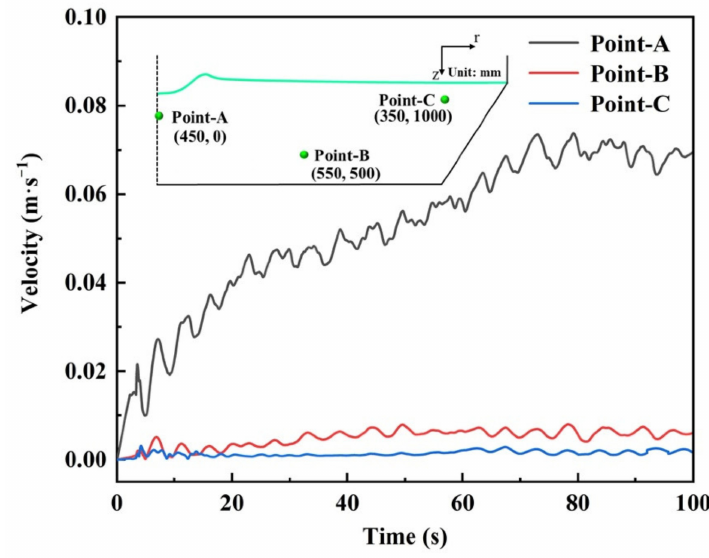
Figure 7. Velocity change in three different monitoring